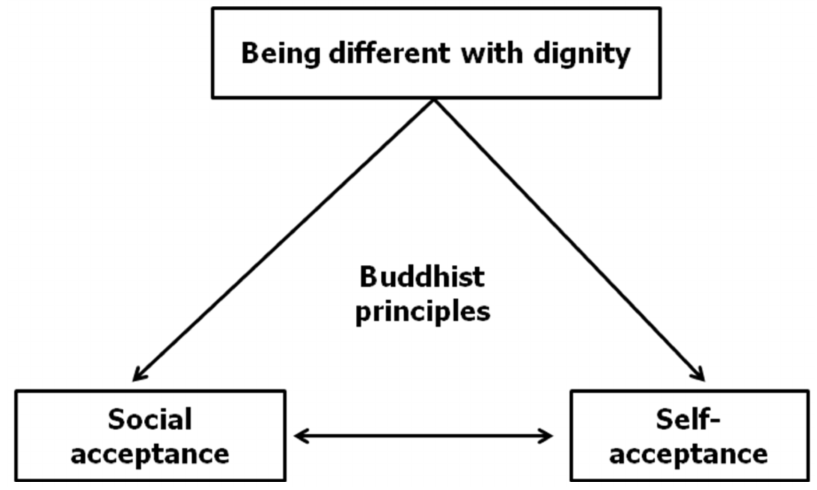
Figure 1. Buddhist wisdom towards